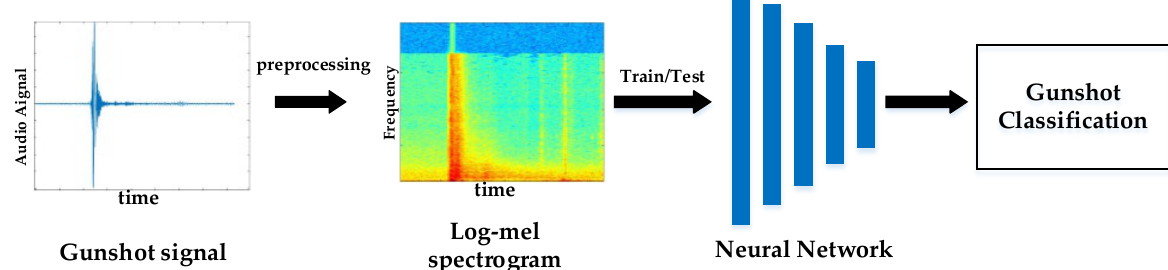
Figure 2. This method consists of two parts: gunshot preprocessing and a gunshot recog- nition network. As the first step, the muzzle blast and the shock wave generated by the gunshot are preprocessed, in which the one-dimensional acoustic signal is converted into the corresponding two-dimensional Log-Mel image. A neural network model is then constructed by use of knowledge distillation [16]. Finally, the gun category is identified based on the gunshot information.